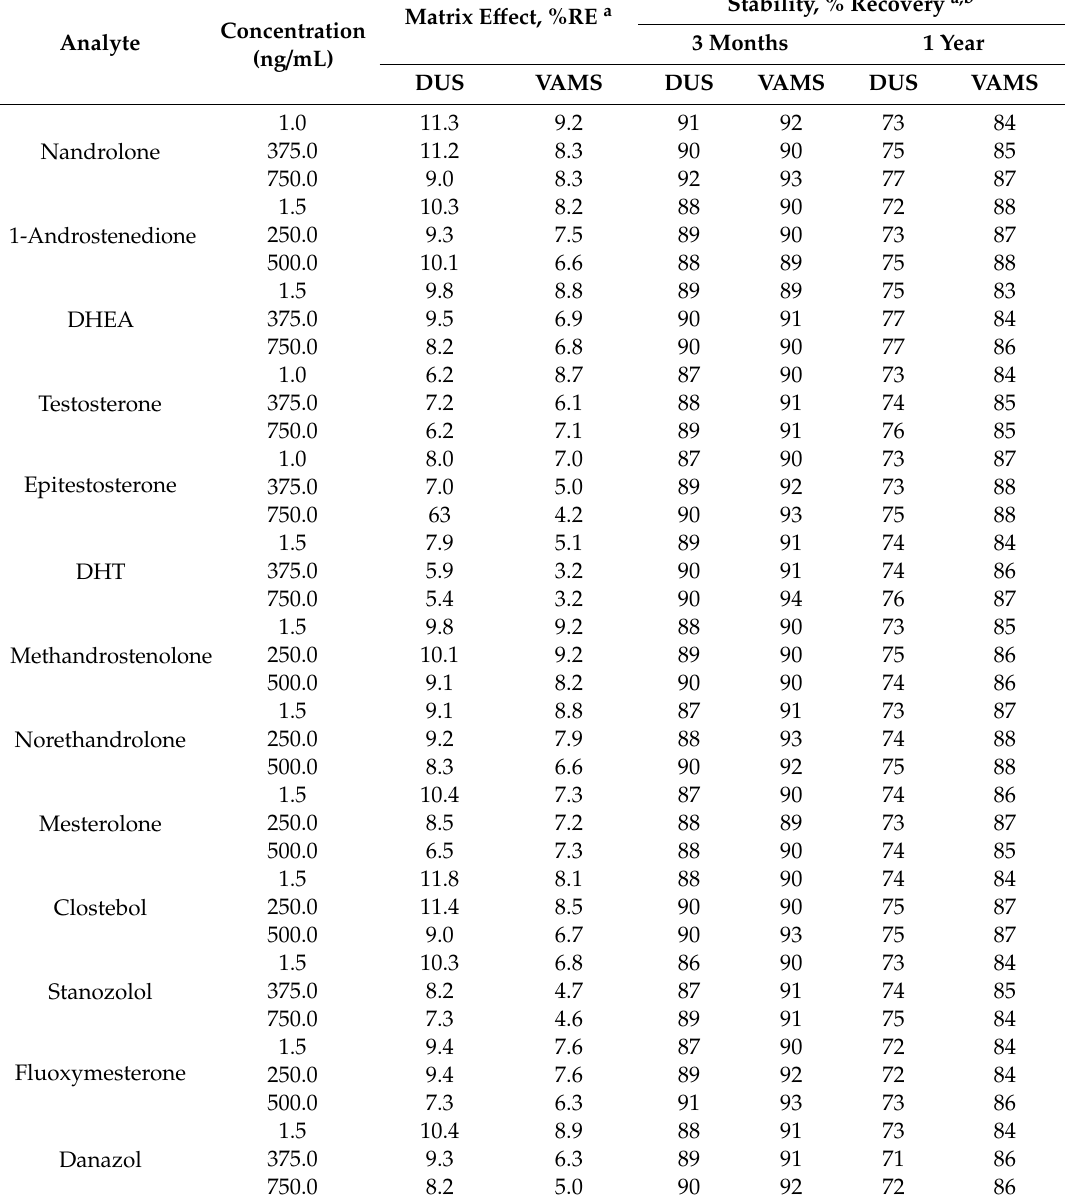
Table 6. Matrix e ff ect and